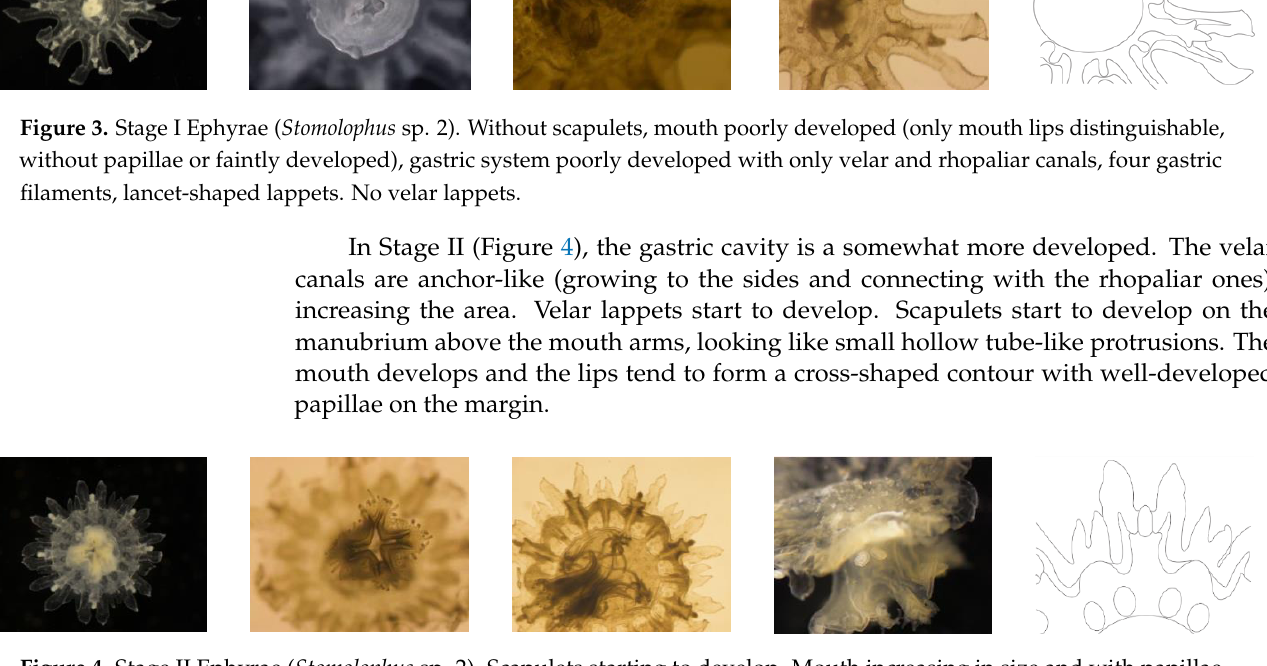
Figure 4. Stage II Ephyrae ( Stomolophus sp. 2). Scapulets starting to develop. Mouth increasing in size and with papillae at the margin. Gastric system developing with connection of rhopaliar and velar canals forming a ring canal at the rim. Rhopaliar lappets are still lancet shaped, but becoming more rhomboid, velar lappets appearing between rhopaliar ones.